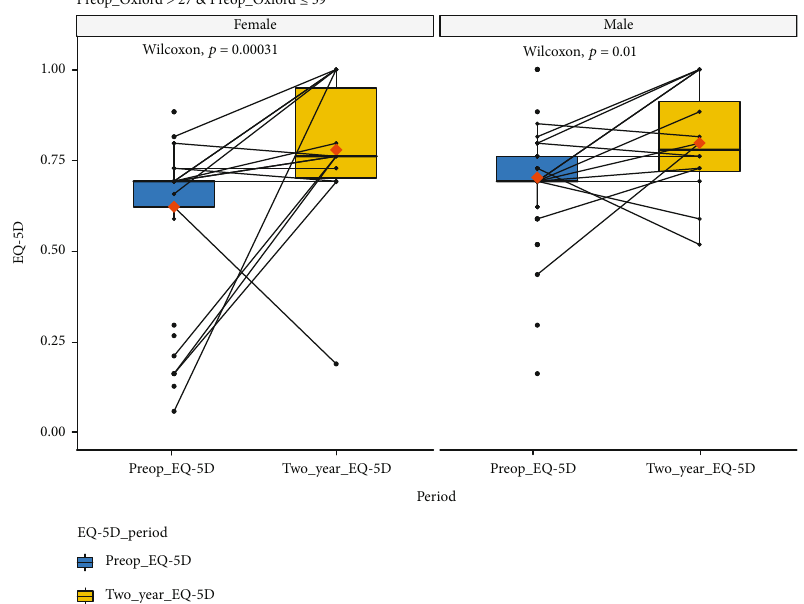
Figure 3: EQ-5D scores at baseline and 2-year follow-up for all those with >27OKS ≤ 39 . Male and female data have been plotted separately. x -axis: EQ-5D for the quality-of-life score at preoperative baseline and at two-year follow-up. y -axis: EQ-5D for the quality-of-life score value; boxplot showing L -estimators: outliers plotted as individual points at 2-year follow-up. Full data tabulated in Table 2. Connecting lines: heuristic visualization of single-patient trajectories of variation of EQ-5D for the quality-of-life score value for function between preoperative baseline and two-year follow-up; plotted with R (version 4.0.0 or higher; libraries ggpubr and PairedData). Source: authors ’